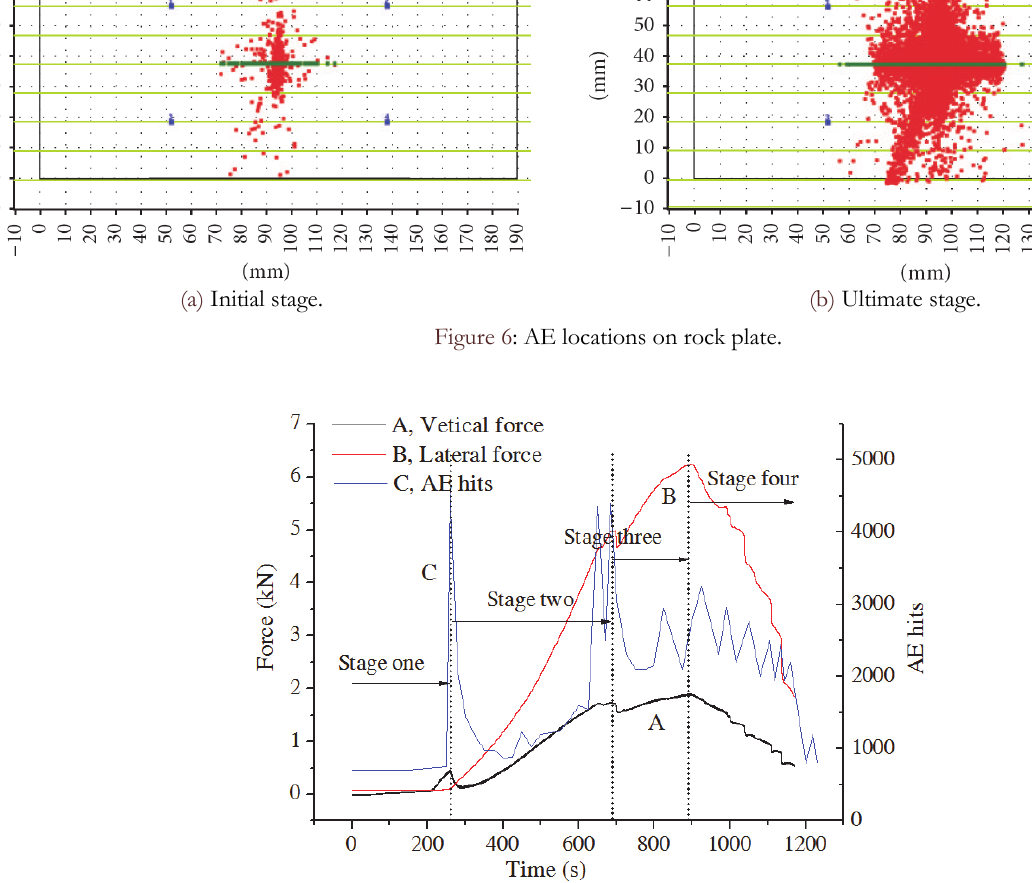
Figure 7: AE hits and force-displacement curves under the concentrated